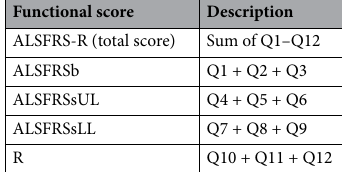
Table 3. Functional scores and sub-scores according to ALSFRS-R.